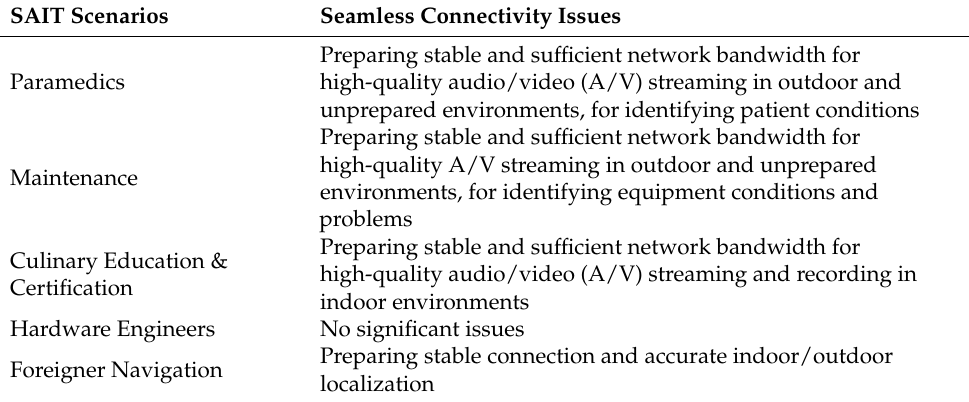
Table 9. Seamless connectivity issues in SAIT scenarios.